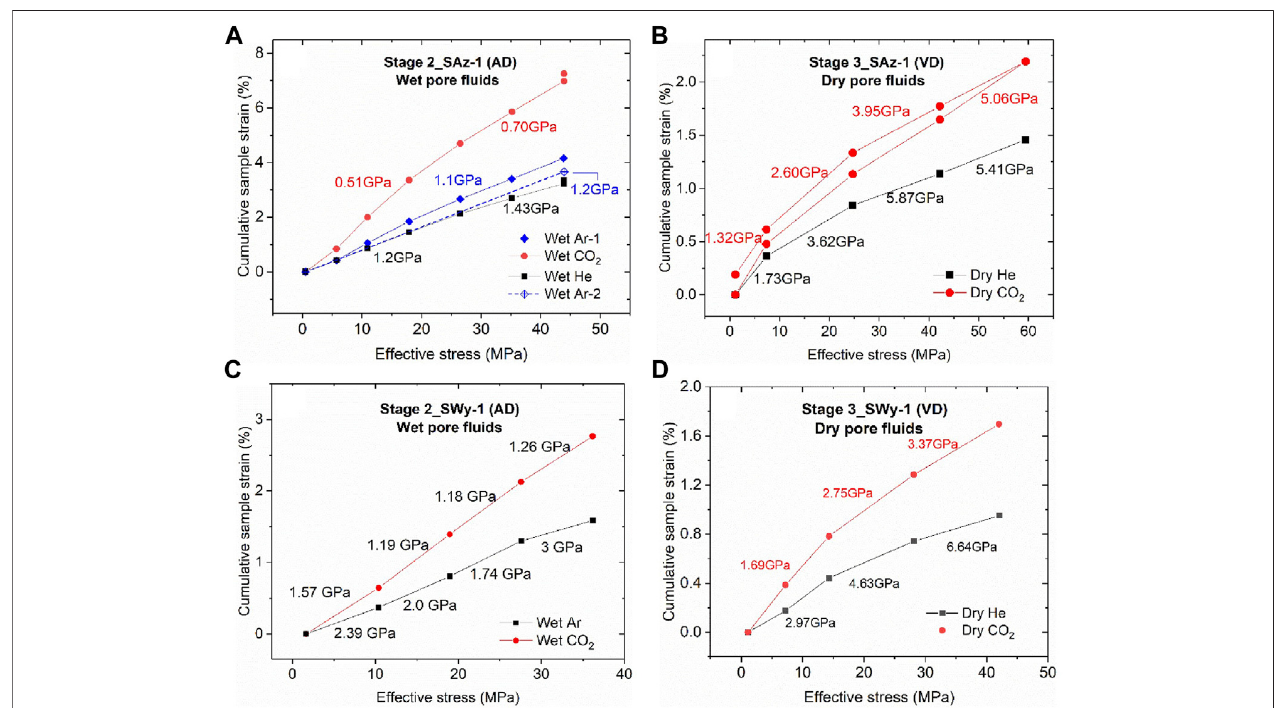
FIGURE 7 | Cumulative compressive sample strains, measured at equilibrium per stress step, plotted against applied effective stresses, for the Stage 2 and 3 stress cycling experiments performed on both the SAz-1 and SWy-1 samples. Cumulative sample strains are calculated relative to sample thickness at the lowest effective stress applied, i.e. lowest effective stress in each plot. Values of cumulative strain measured at the same effective stress but in different loading cycles were averagedand only themeanvaluewasplotted foragivenstress.The apparent stiffness values(GPa) shown perstressintervalaretangent moduli ( C app (cid:2) Δσ e / Δε ) derived from equilibrium strain-stress data obtained over the corresponding interval. (A) Stage 2 data for the initially AD Ca-SAz-1 sample. (B) Stage 3 data for the VD SAz-1 sample. (C) Stage 2 data for the initially AD Na-SWy-1 sample. (D) Stage 3 data for the VD Na-SWy-1 sample.